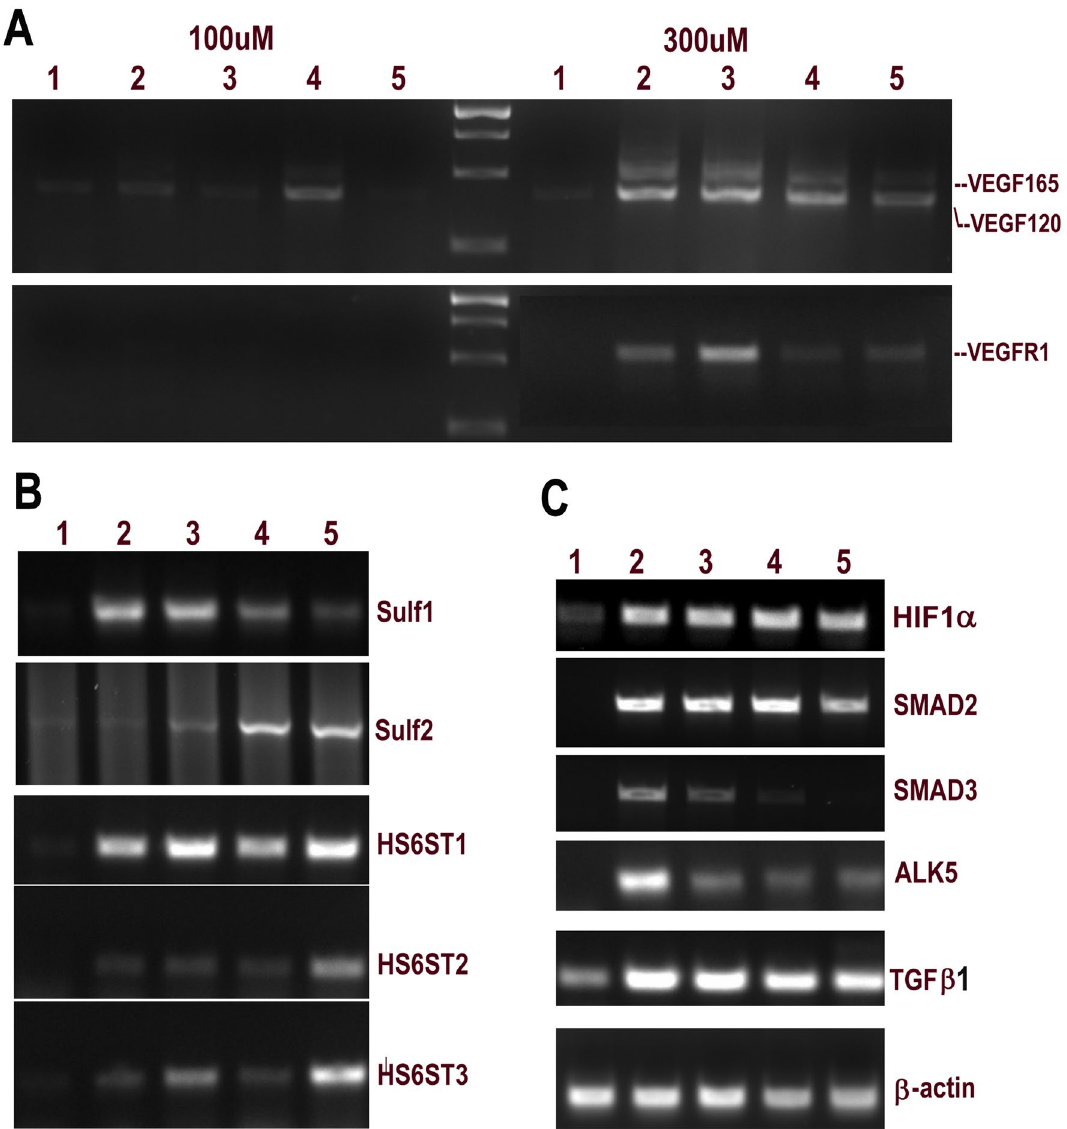
Figure 7. RT PCR analysis showing changes in vegfr1 and vegf variants in HMec1 endothelial cells at lower (100 µM) and higher (300 µM) levels of hypoxia in untreated (1) and CoCl2-treated cells for 3 h (2), 24 h (3), 72 h (4) and 96 h (5) of hypoxia. Changes in Sulf1, Sulf2, sulfotransferases and components of TGFβ cell signalling and β-actin were examined following treatment with 300 µM CoCl2. CoCl2 induced hypoxia in such cells was confirmed by rapid activation of